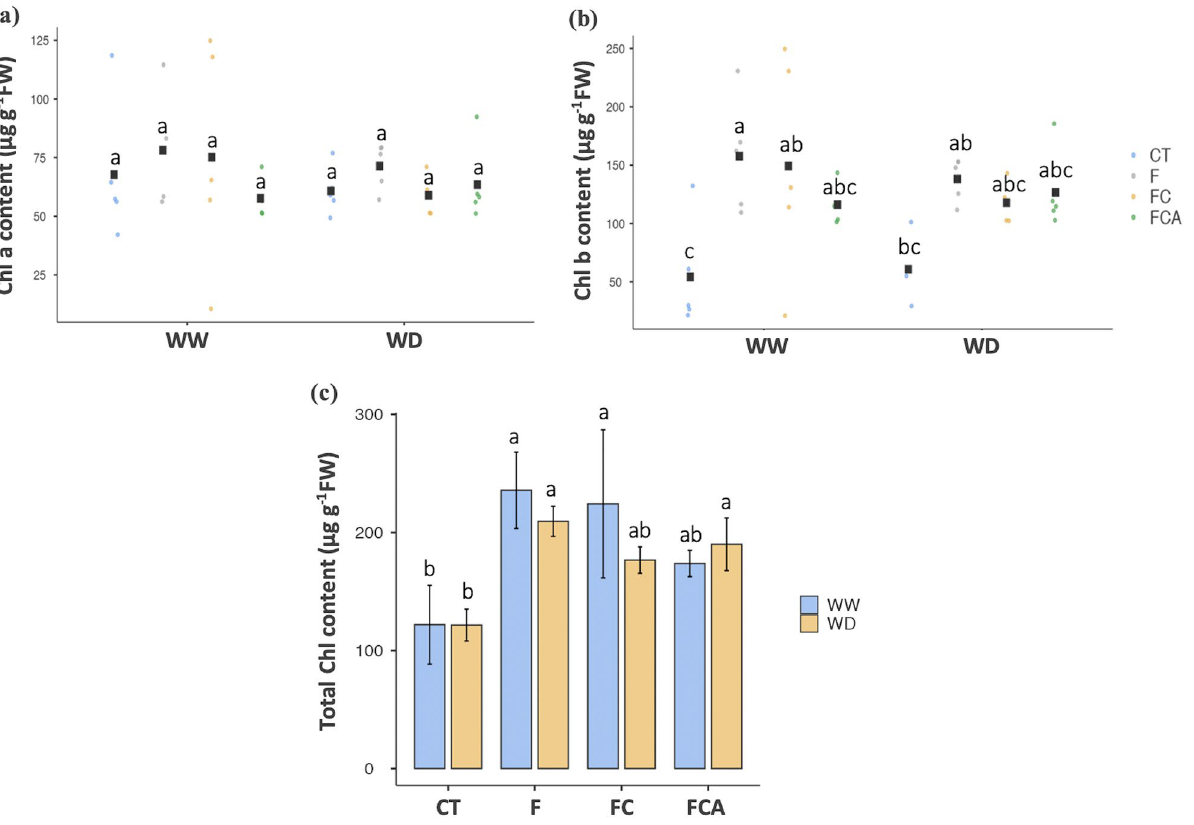
Figure 2. Chlorophyll, Chl a and b ( a and b ) and total chlorophyll content ( c ) in rice cv. Leum Pua that inoculated with or without AMFs (F, FC, FCA, and CT) on the 21st day of well-watered and water deficit conditions. Statistical data access with a minimum of n = 4 and mean ± standard deviation. Different letters along plots represent significant difference at p =